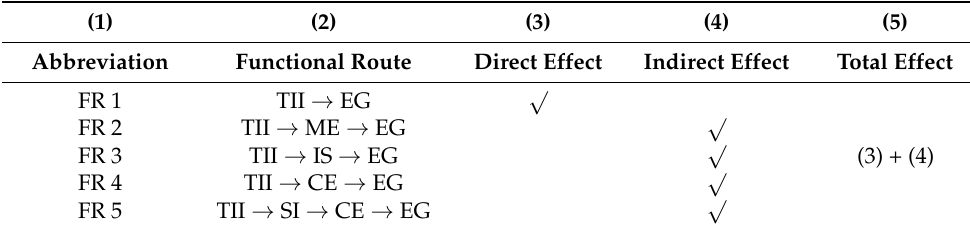
Table 11. Functional routes of the effects of TII on EG.